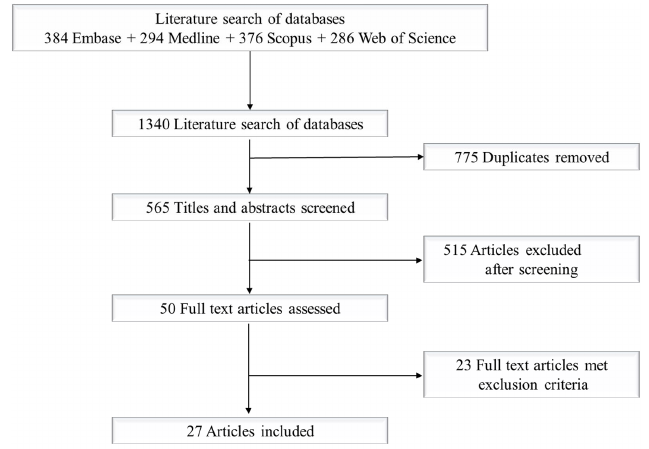
Figure 1. PRISMA flow chart of the literature screening and selection processes.